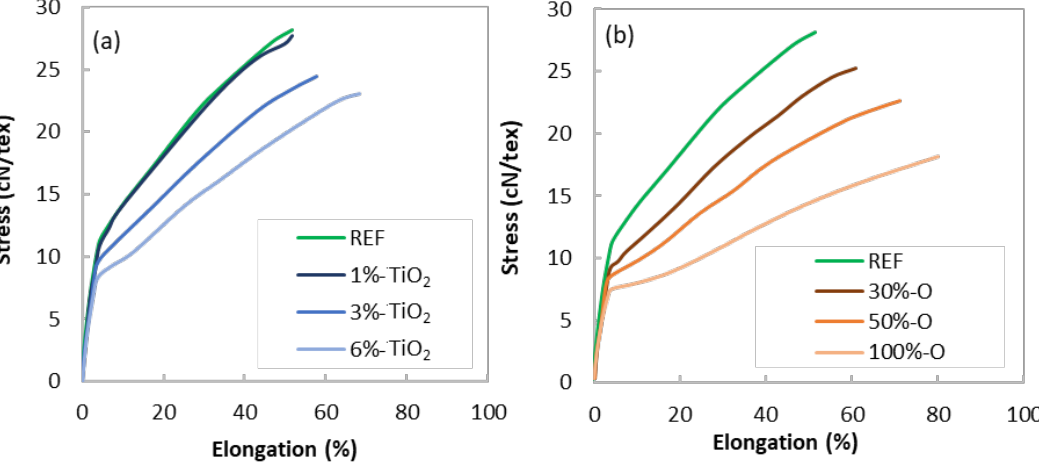
Figure 8. Stress versus elongation of filaments; ( a ) REF + TiO 2 from masterbatch blends; ( b ) Standard rPET + opaque rPET blends.